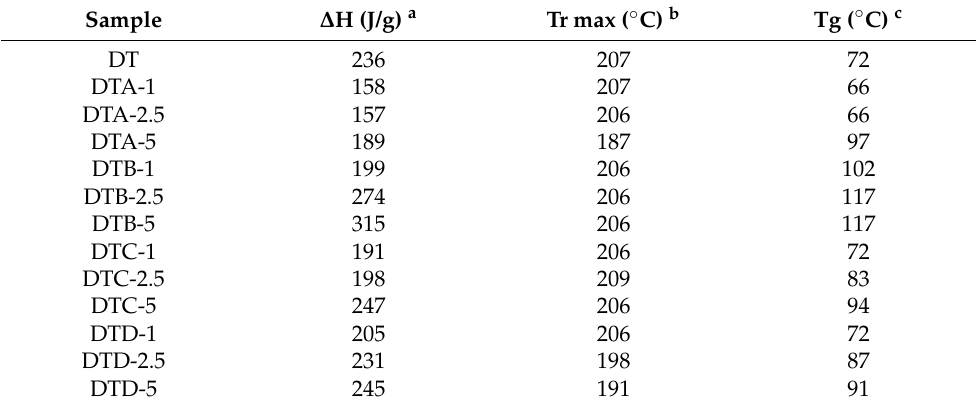
Table 3. Relevant DSC data of bio-based DTA, DTB, DTC and DTD